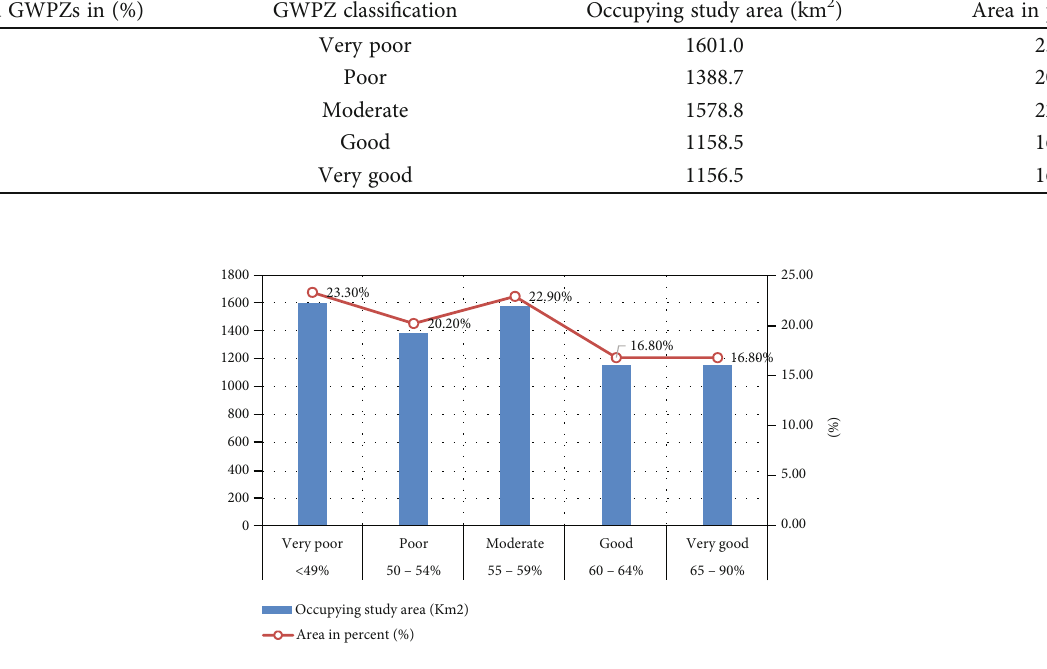
Figure 14: Groundwater potential